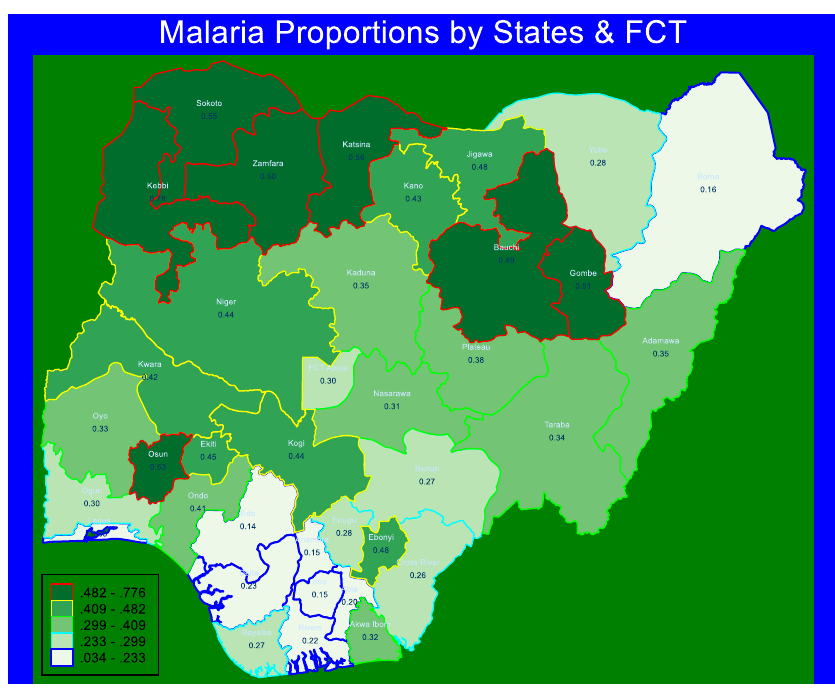
Figure 1. Spatial plot of the proportion of malaria positive children 6 – 59 months of age in Nigeria by states and FCT.